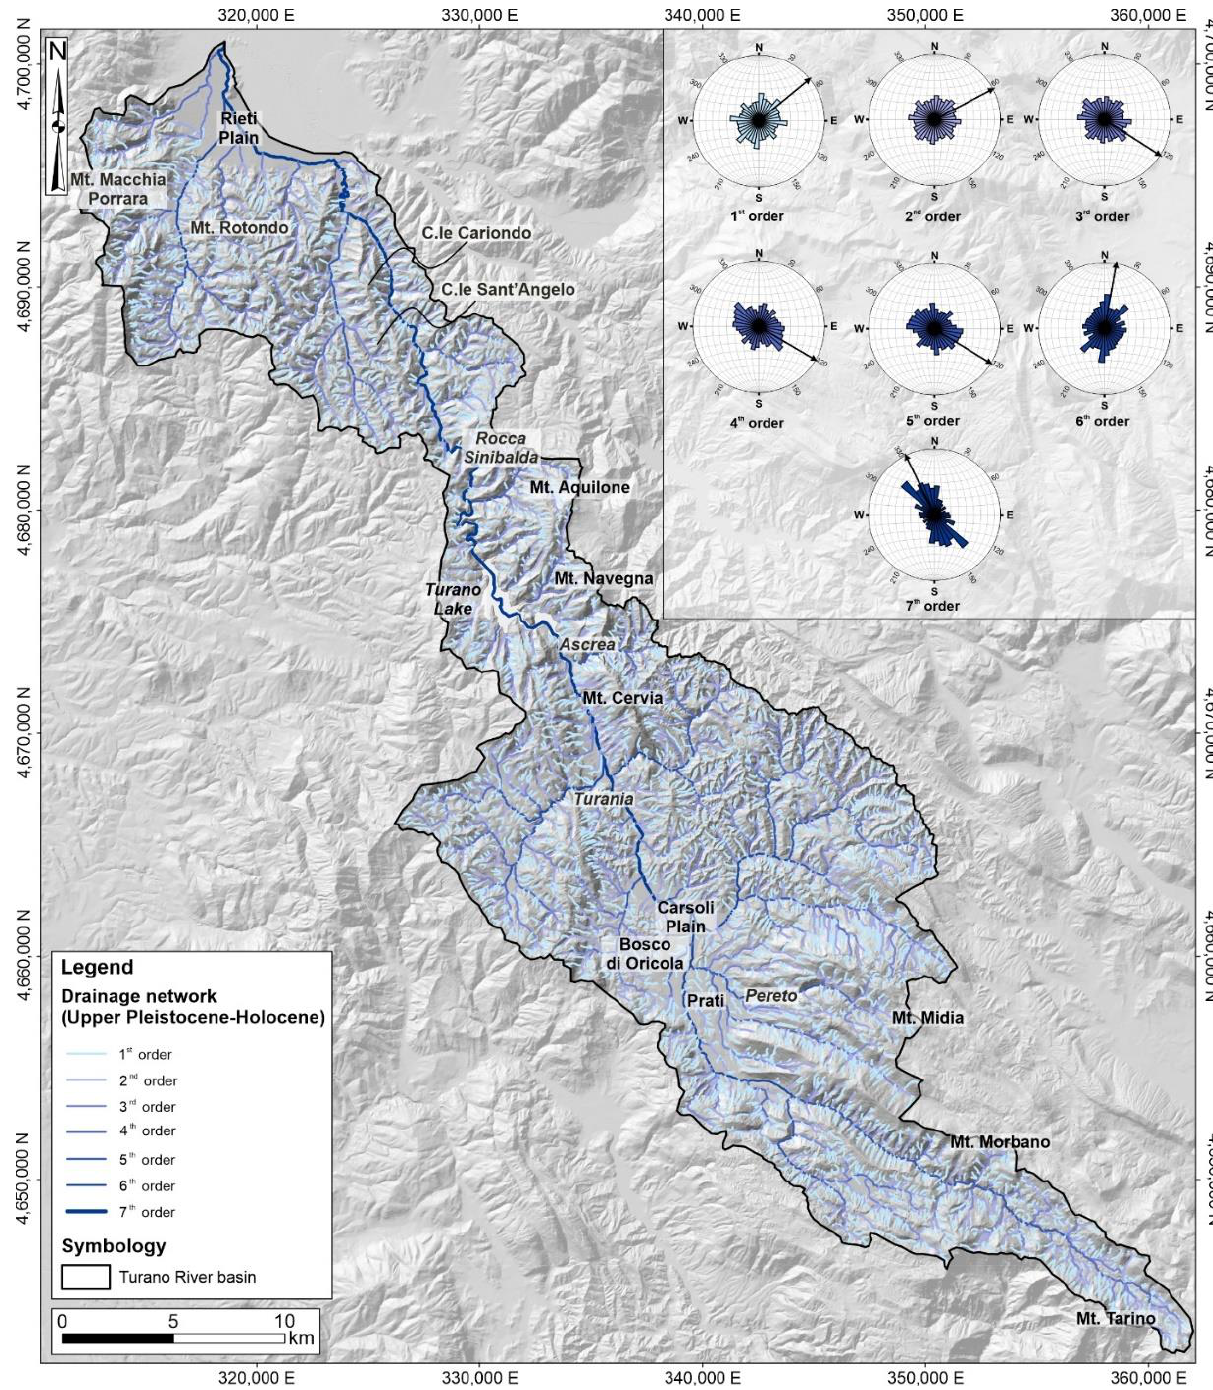
Figure 8. Drainage network of the Turano River from Upper Pleistocene to Holocene, mainly dominated by SE-NW-oriented drainage. Frequency-weighted rose diagrams show the azimuthal direction for each stream order of the Turano River, with black arrows indicating the mean vectors.